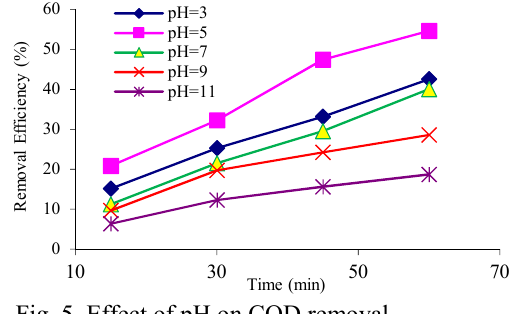
Fig. 5. Effect of pH on COD